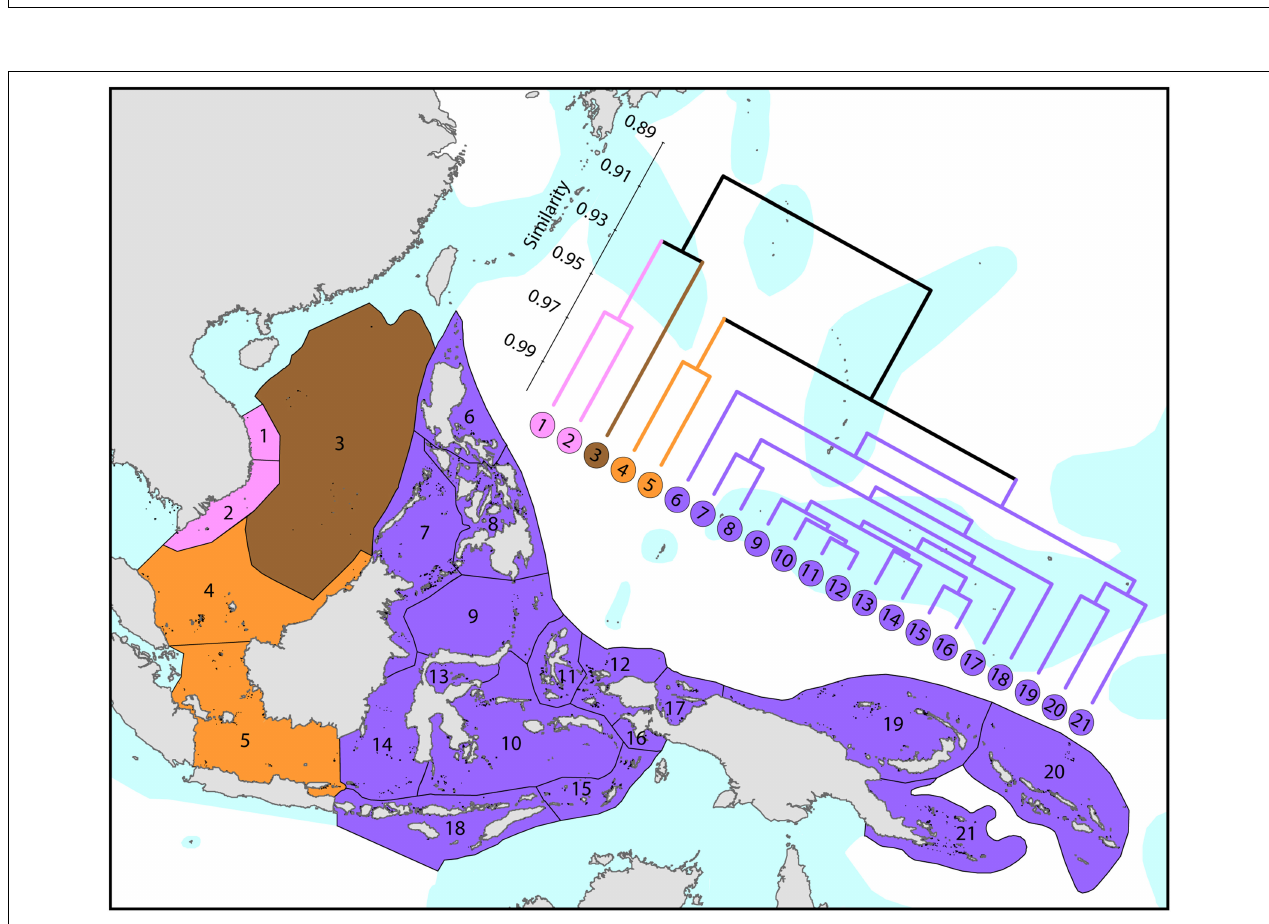
FIGURE 5 | Global pattern of affinity truncated at the highest 22 divisions in order to provide clarity. Note (a) that excluded ecoregions (colored pale blue) are included in relevant regional